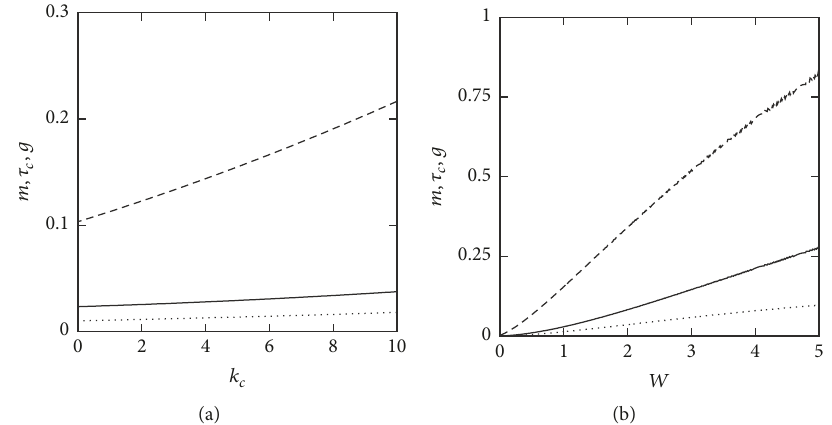
Figure 3: Dependence of 𝑚 , 𝜏 𝑐 , and 𝑔 on 𝑘 𝑐 and 𝑊 . The solid, dashed, and dotted curves represent 𝑚 , 𝜏 𝑐 , and 𝑔 , respectively. (a) Dependence of 𝑚 , 𝜏 𝑐 , and 𝑔 on 𝑘 𝑐 . 𝛼 = 5.0 and 𝑊 = 1.0 . In the calculation of 𝑔 , 𝜏 is chosen as 𝜏 = 𝜏 𝑐 . As 𝑀 3 is positive, 𝑔 for the case 𝜏 < (>) 𝜏 𝑐 is smaller (larger) than this curve. (b) Dependence of 𝑚 , 𝜏 𝑐 , and 𝑔 on 𝑊 . 𝛼 = 5.0 and 𝑘 𝑐 = 5.0 . In the calculation of 𝑔 , 𝜏 is chosen as 𝜏 = 𝜏 𝑐